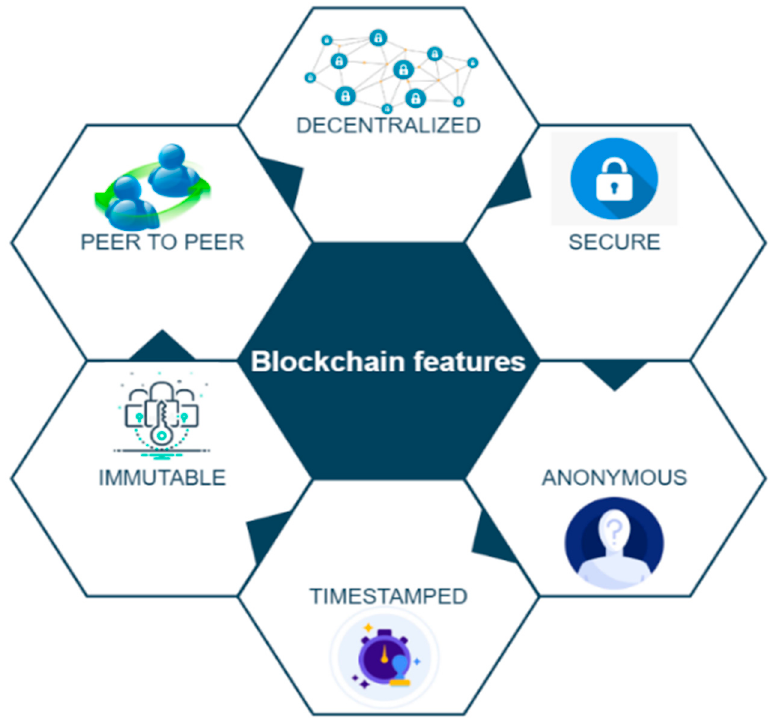
Figure 1. Blockchain